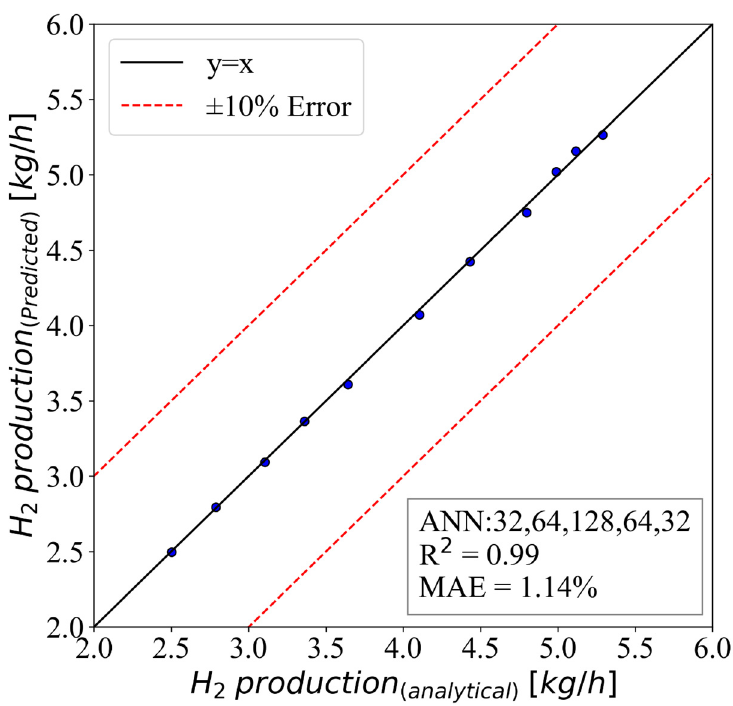
Figure 15. The ANN model of 𝐻 (cid:2870) production with an HL structure of (32,64,128,64,32).